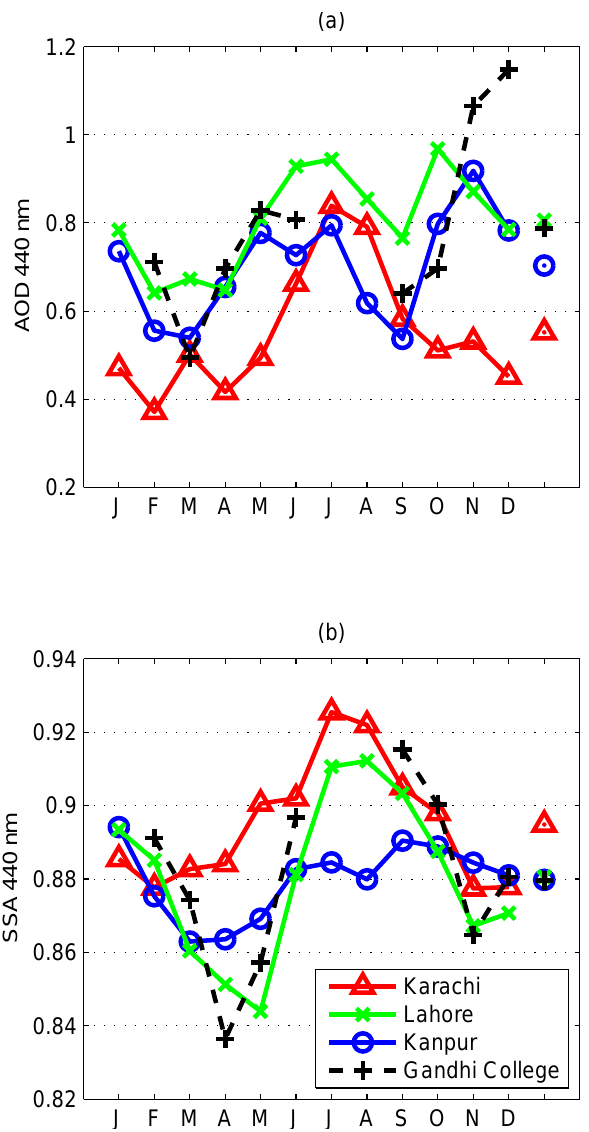
Figure 2. Monthly mean AOD and SSA at 440nm for our selected AERONET sites. Annual means are indicated by a symbol after De-